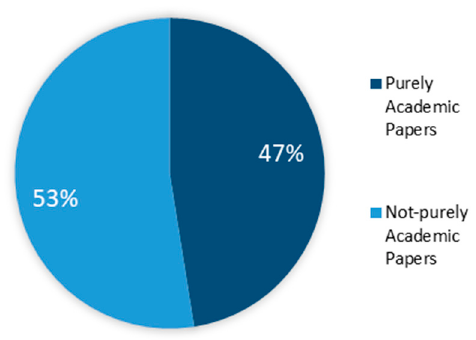
Figure 4. Purely and non-purely academic papers. Table 5. Papers’ methodologies.